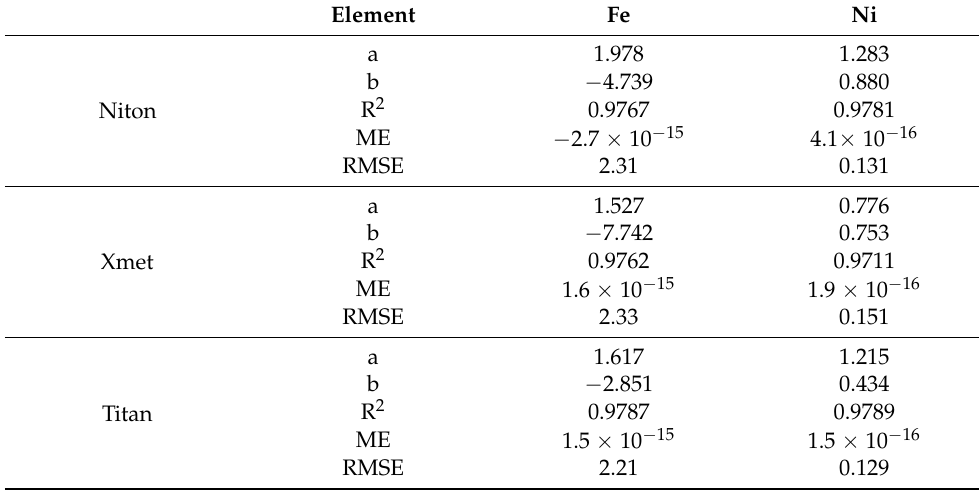
The Table 7 quantifies the mean error and the root-mean-square error obtained by a linear correction law. Table 7. Parameters of the linear regression between in situ measurements of water-saturated samples and contents measured by reference laboratory for the two elements and for the three devices (a: Slope, b: y-intercept, R 2 : Coefficient of determination, ME: Mean error, RMSE: Root-mean-square error). Element Fe Ni